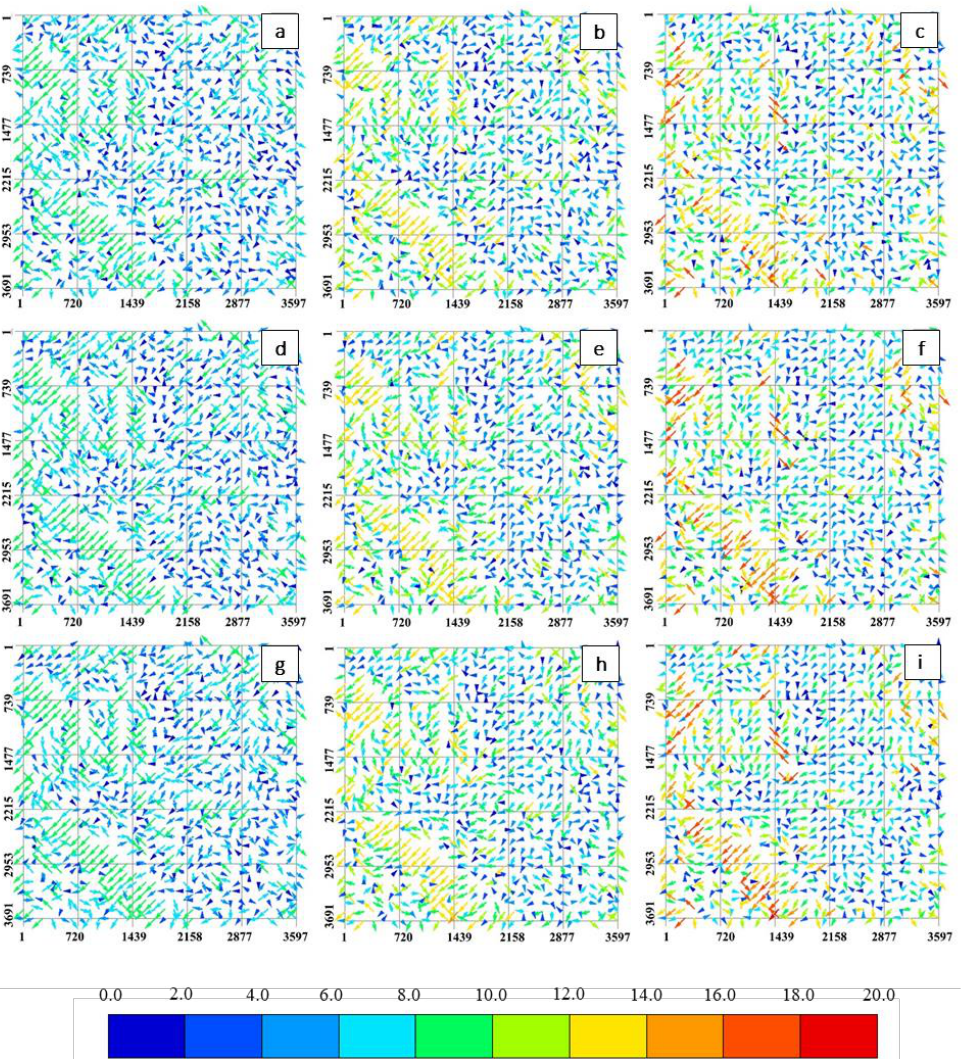
Figure 11. Generated shifting vector for nine scenarios. ( a )–( i ) correspond to the parameter combinations shown by the scenario numbers (2)–(10) in Table 2, respectively.